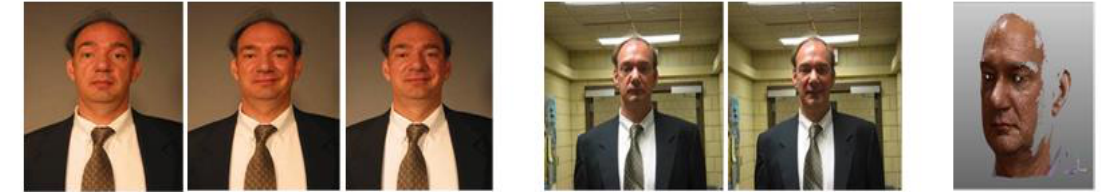
Figure 10. Samples from one person session: controlled stills, uncontrolled stills, and 3D shape.